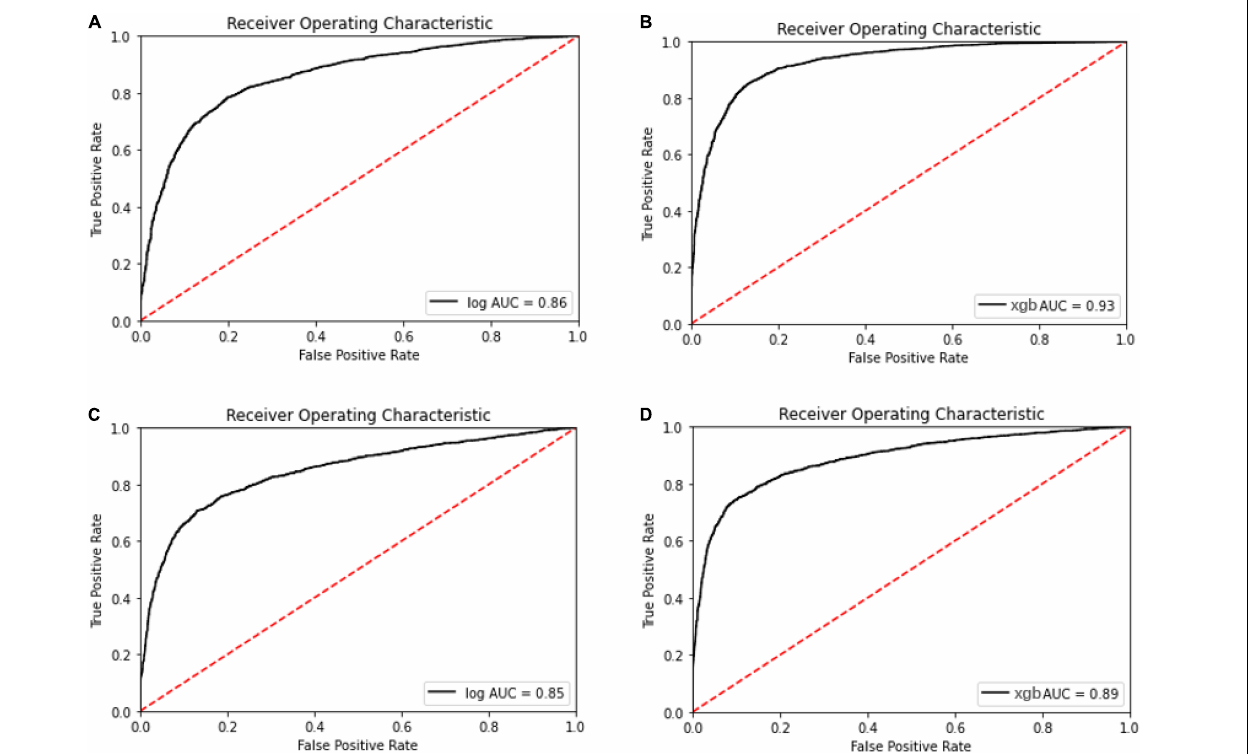
FIGURE 3 | Receiver operating characteristic curve for the oxacillin and clindamycin susceptibility prediction under replication cohort in multi-label learning model, respectively. The area under the curve (AUC) is noted in the curve. (A) Receiver operating characteristic (ROC) for the oxacillin susceptibility prediction in replication cohort using Lowest Power set with logistic regression (LR); (B) ROC for the oxacillin susceptibility prediction in replication cohort using Lowest Power set with XGBoost; (C) ROC for the clindamycin susceptibility prediction in replication cohort using Lowest Power set with LR; and (D) ROC for the clindamycin susceptibility prediction in replication cohort using Lowest Power set with